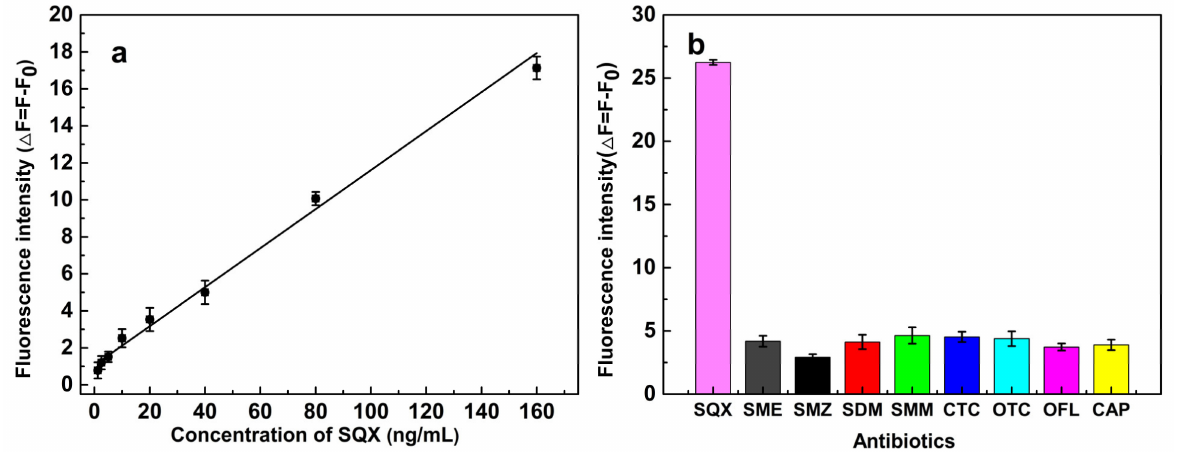
Figure 6. ( a ) Linear fitting of the fluorescence intensity of the aptasensor; ( b ) Selectivity of the fluorescent aptasensor for SQX and other antibiotics: SME, SMZ, SDM, SMM, TET, OTC, OFL, and CAP.